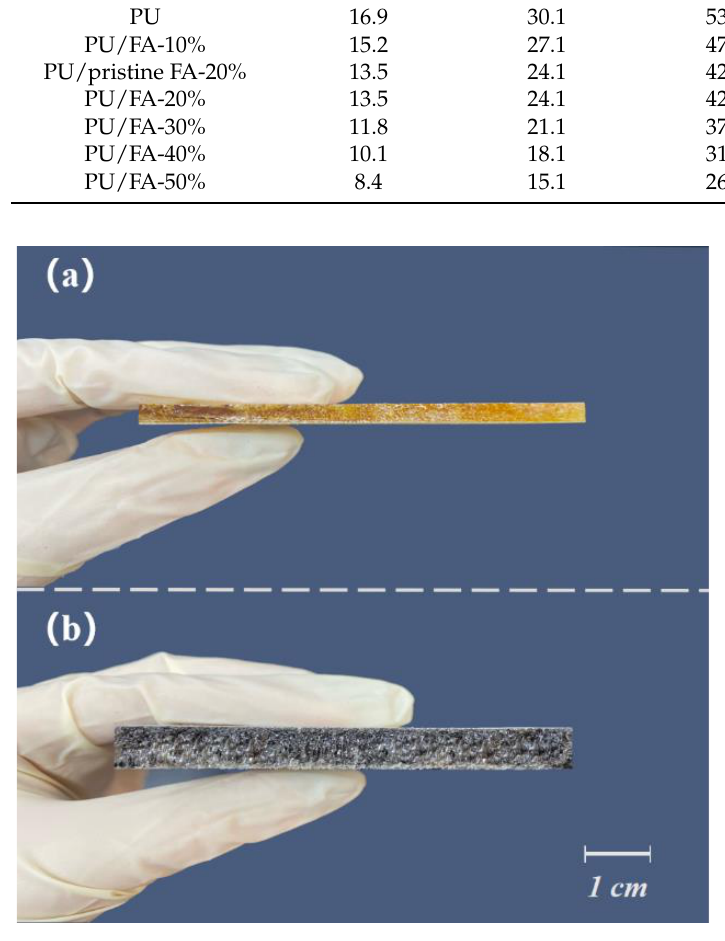
Figure 1. A sample section of PU ( a ) and PU/FA composites ( b ).